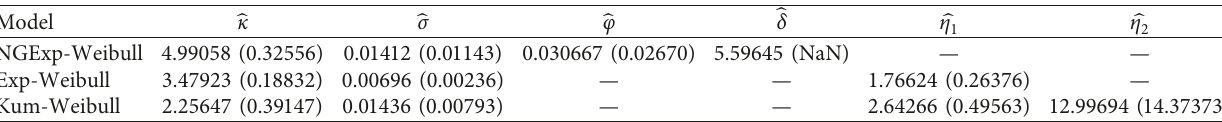
O data. 2 3 , 􏽢 η , and their SEs. 1 2